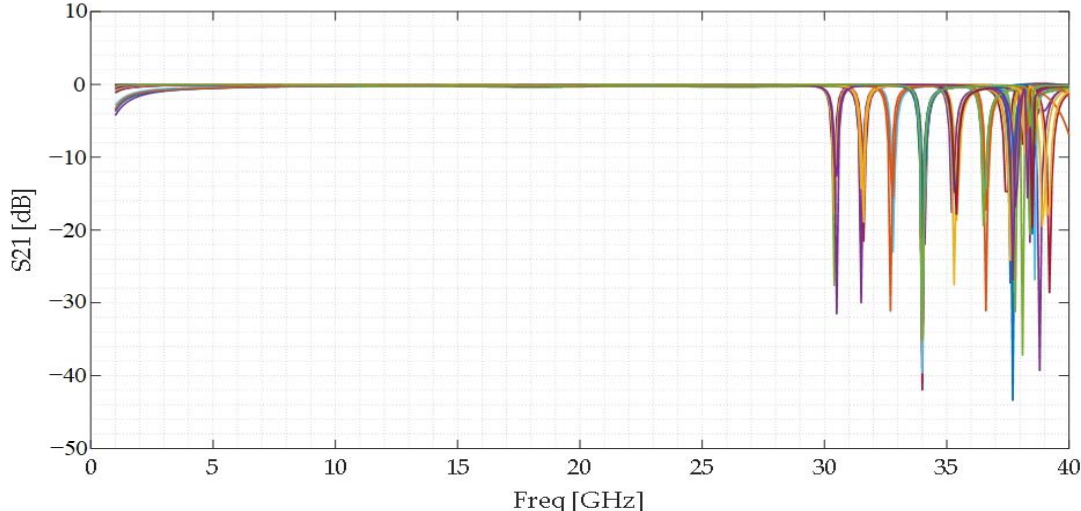
Figure 13. Trend of S 2 1 with frequency under different structural parameters .